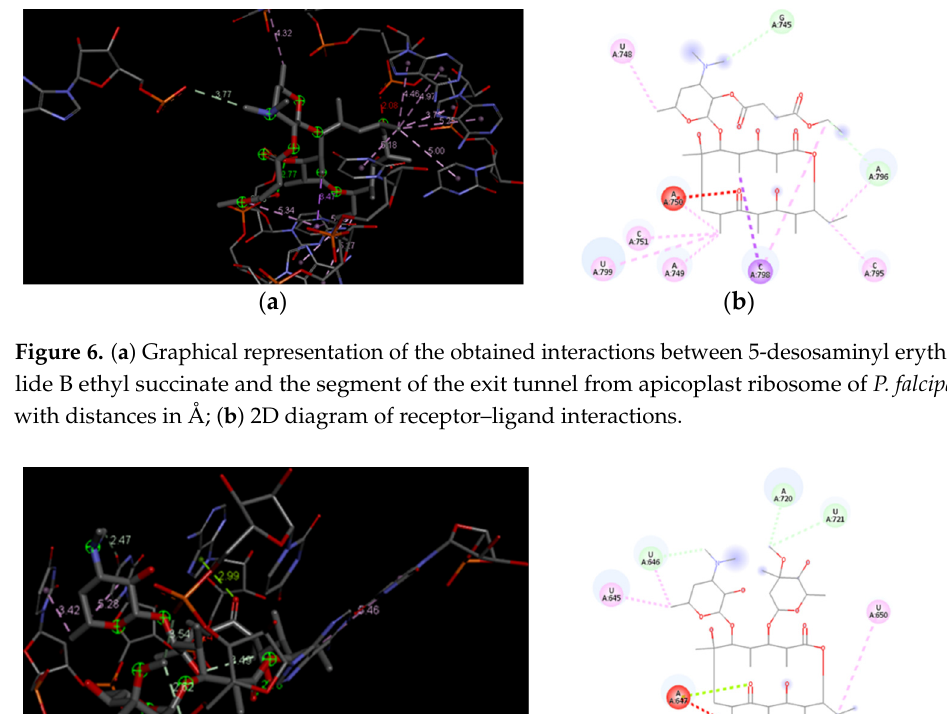
Figure 5. ( a ) Graphical representation of the obtained interactions between erythromycin B 2 ′ -[3- ribosome of P. falciparum : unfavourable bump (red circle), carbon hydrogen bond (light (dimethylaminomethyl)benzoate] and the segment of the exit tunnel from apicoplast ribosome of P. falciparum with distances in Å; ( b ) 2D diagram of receptor–ligand interactions. blue circle), π -Lone pair (light green circle), and π -alkyl (pink circle) (Figure 7).